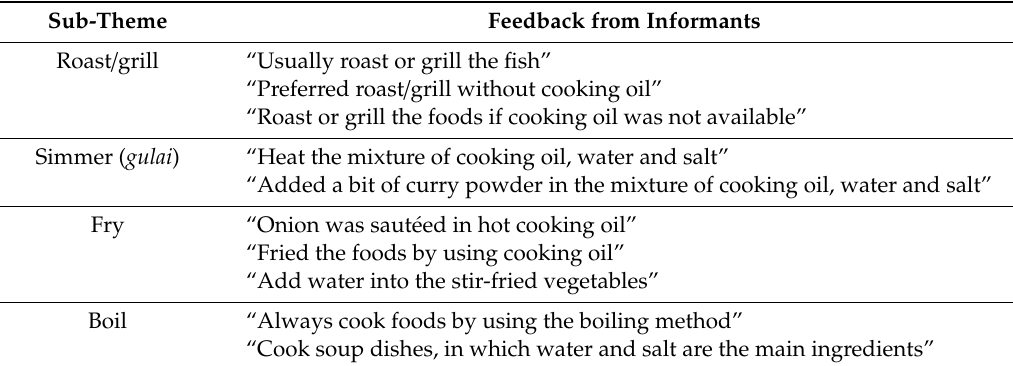
Table 4. Cooking method sub-theme and feedback from